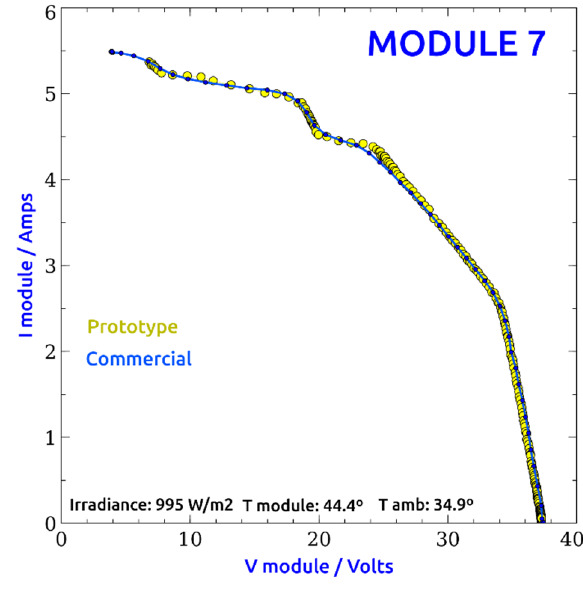
Figure 11. Mixed strategy/commercial tester comparison I-V curves.